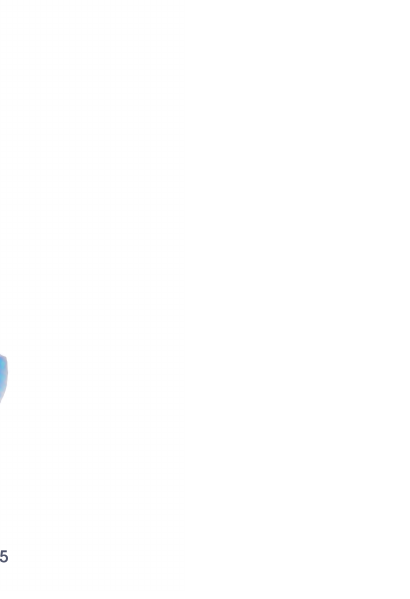
Figure 14. Test case 3: Relative error in the velocity magnitude for the testing-parameter instance = ( 5.9102,3.1179 ) at the systolic peak t = 0.18 s. µ test In Figure 15, we report the streamlines of the blood velocity field, obtained with the FOM and the POD-DL-ROM,for the testing-parameter instance µ t = 0.5 s. In Figure 16, we report instead a detailed view of the pattern of the fluid velocity field obtained for the testing-parameter instance µ highlighting the recirculation of the flow in the bulge and the blood stasis in this region.